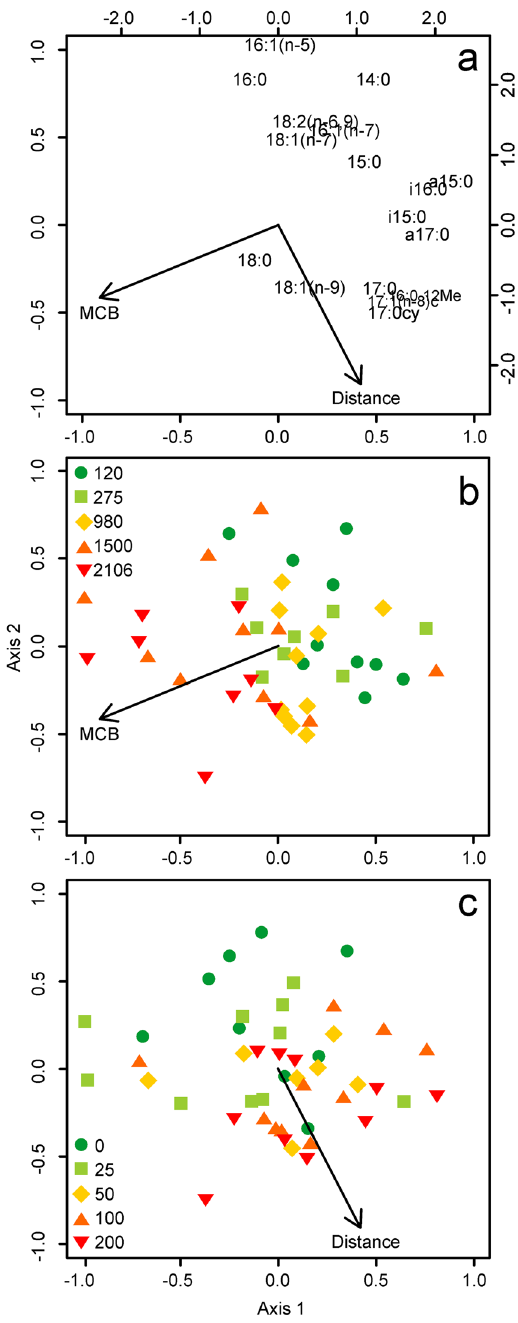
Figure 3. Redundancy analysis distance triplot of phospholipid fatty acid (PLFA) profiles ( δ 13 C) extracted from surficial sediments around 5 fish farms in Scotland. The upper panel ( a ) visualizes how the explanatory variables MCB (maximum consented biomass, tonnes) and distance from the cage edge (m), plotted on the primary axes, were related to the 17 PLFAs (‘species’), plotted on the secondary axes. The lower panels illustrate how the isotopic signatures of PLFAs in each individual sediment samples (‘sites’, n = 46) were related to MCB ( b ) and Distance ( c